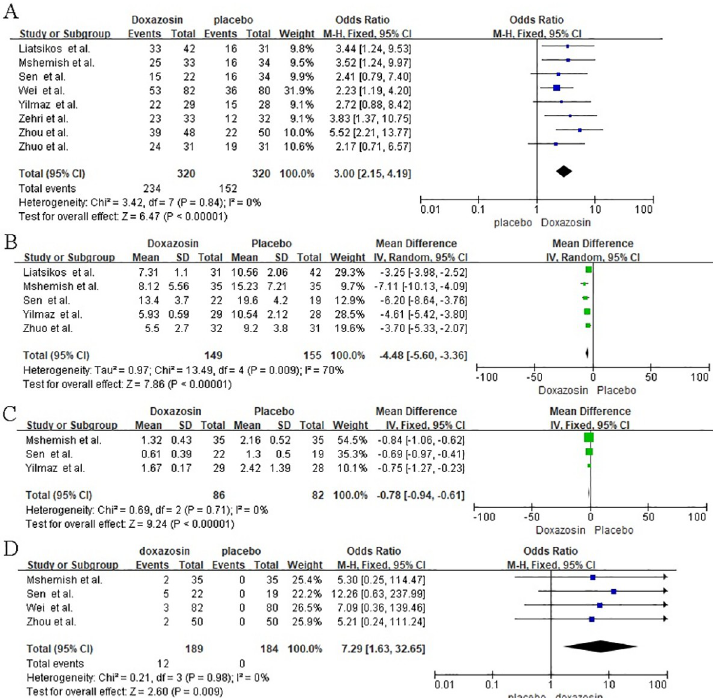
Fig 4. A: Meta-analysis results of expulsion rate between the groups. B: Meta-analysis results of expulsion time between the groups. C: Meta-analysis results of pain episodes between the groups. D: Meta-analysis results of drug adverse reaction between the groups.